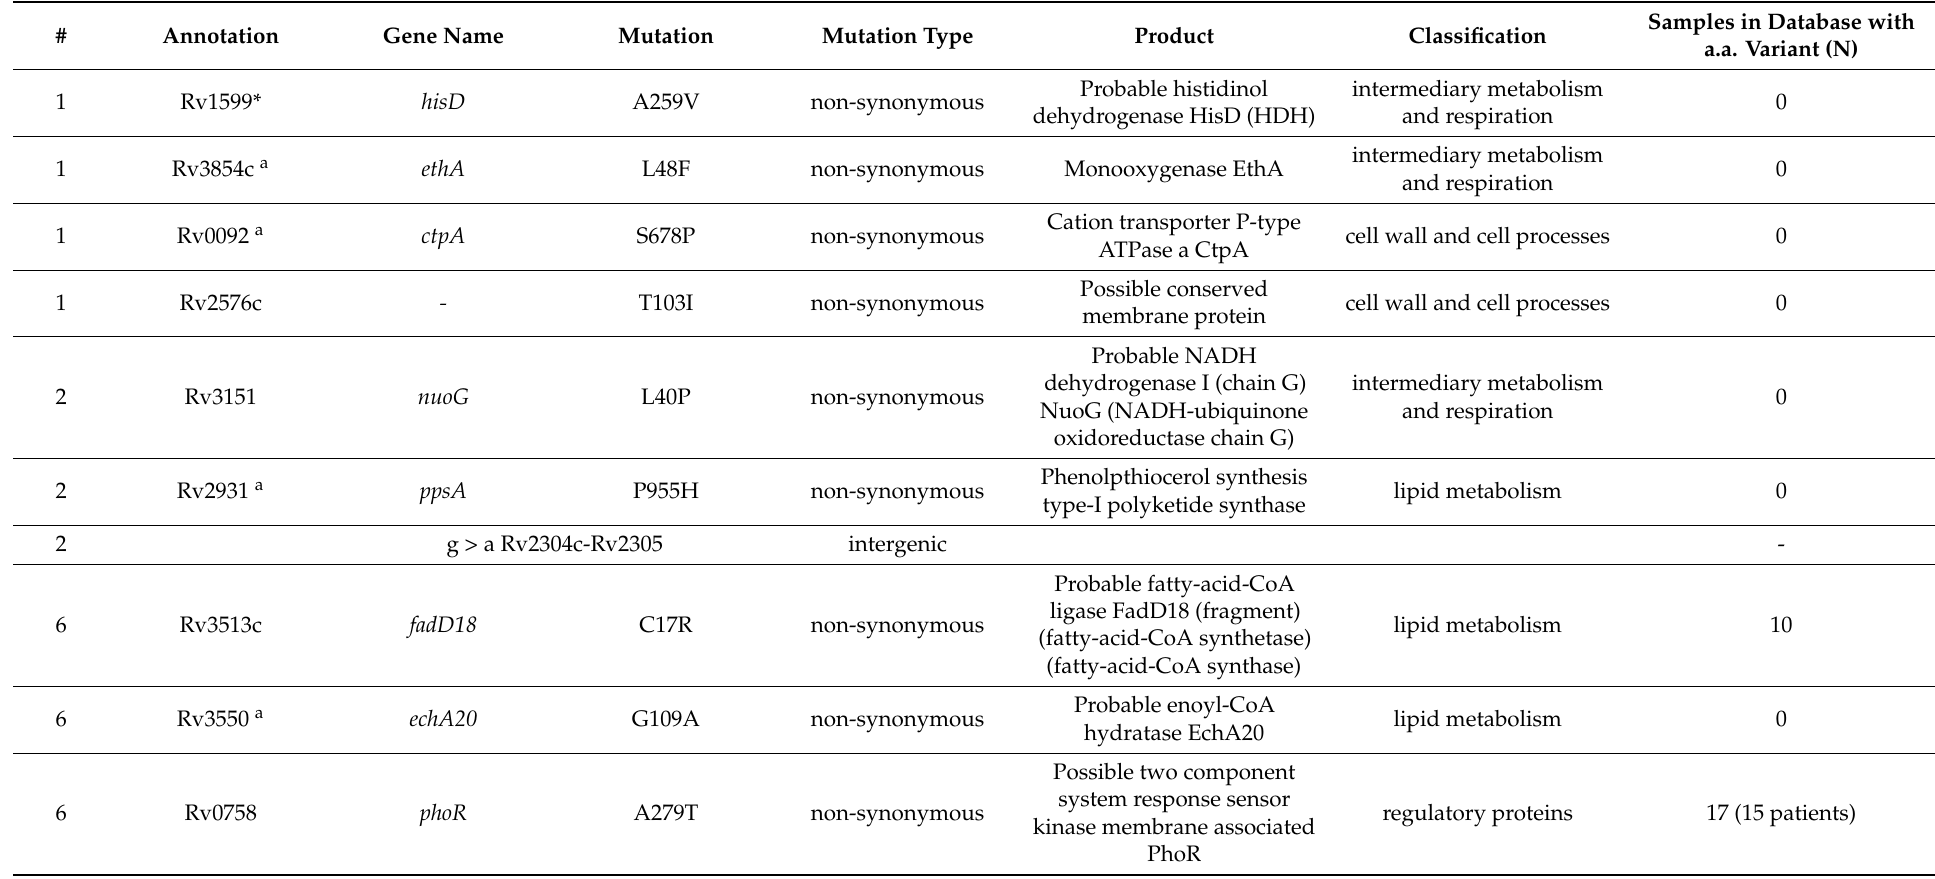
Table 4. SNP differences in lipid-grown Sm+/Cx − samples, collected at least a year later following TB treatment, compared to paired patient baseline samples, collected at study